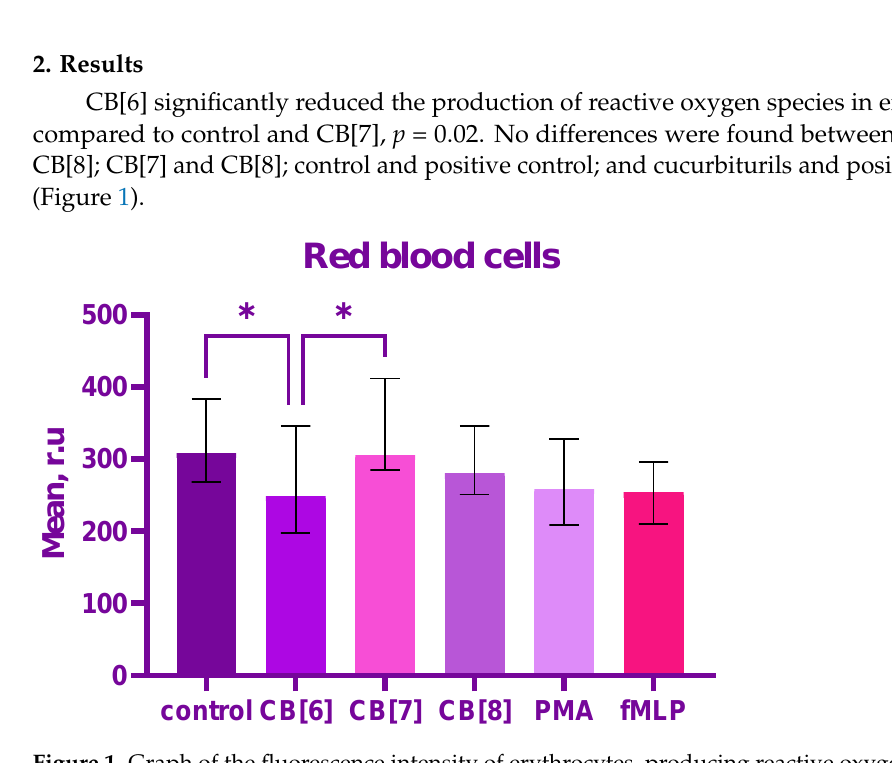
Figure 1. Graph of the fluorescence intensity of erythrocytes, producing reactive oxygen species in response to stimulation with cucurbiturils (CB[6,7,8]) during 1 h. Data are presented as median ± interquartile range with n = 10. * p < 0.05 by employing one-way ANOVA, Friedman test. Moreover, CB[6] and CB[7] reduced the production of reactive oxygen species in platelets compared to the control ( p = 0.04 and p = 0.01, respectively). Interestingly, CB[7] reduced ROS production compared to PMA positive control, p = 0.01 and CB[6] had a tendency compared to PMA, p = 0.05 (Figure 2). No significant difference was found between cucurbiturils, CB[8] and control.